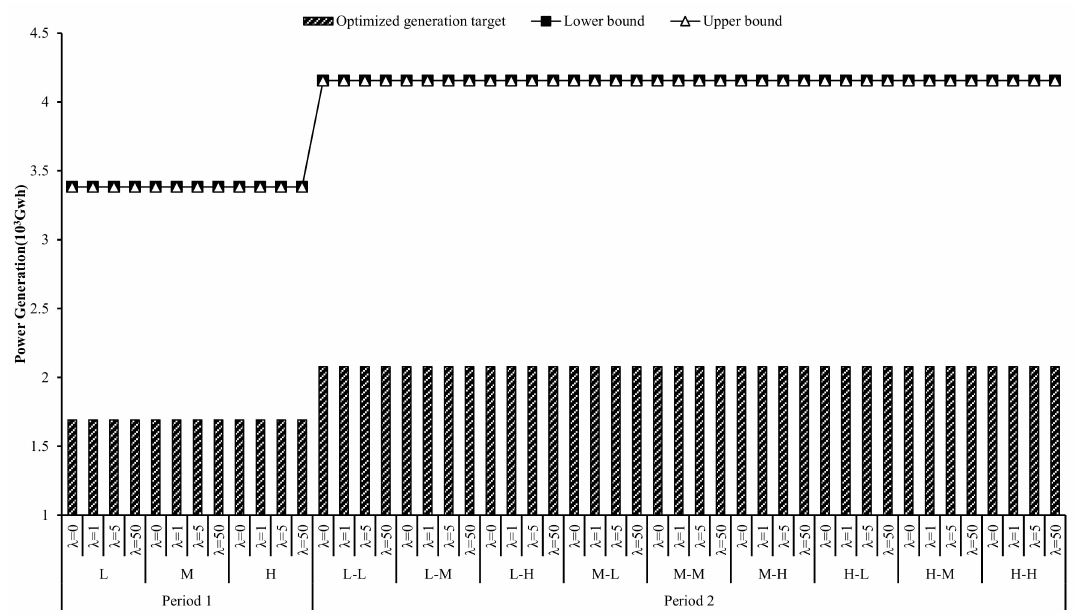
Figure 4. The optimized wind power generation during the whole planning horizon.